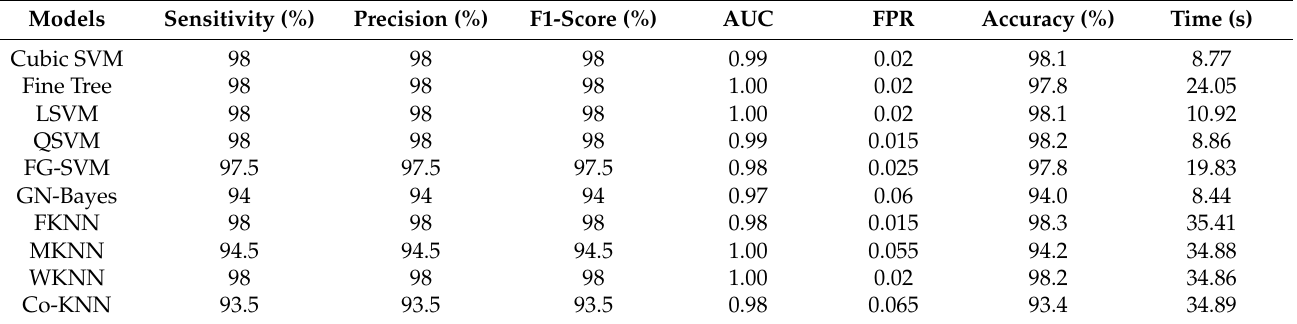
Table 16. Classification results using MEWOA on Fine-tuned MobilenetV2 deep features for IN- breast.